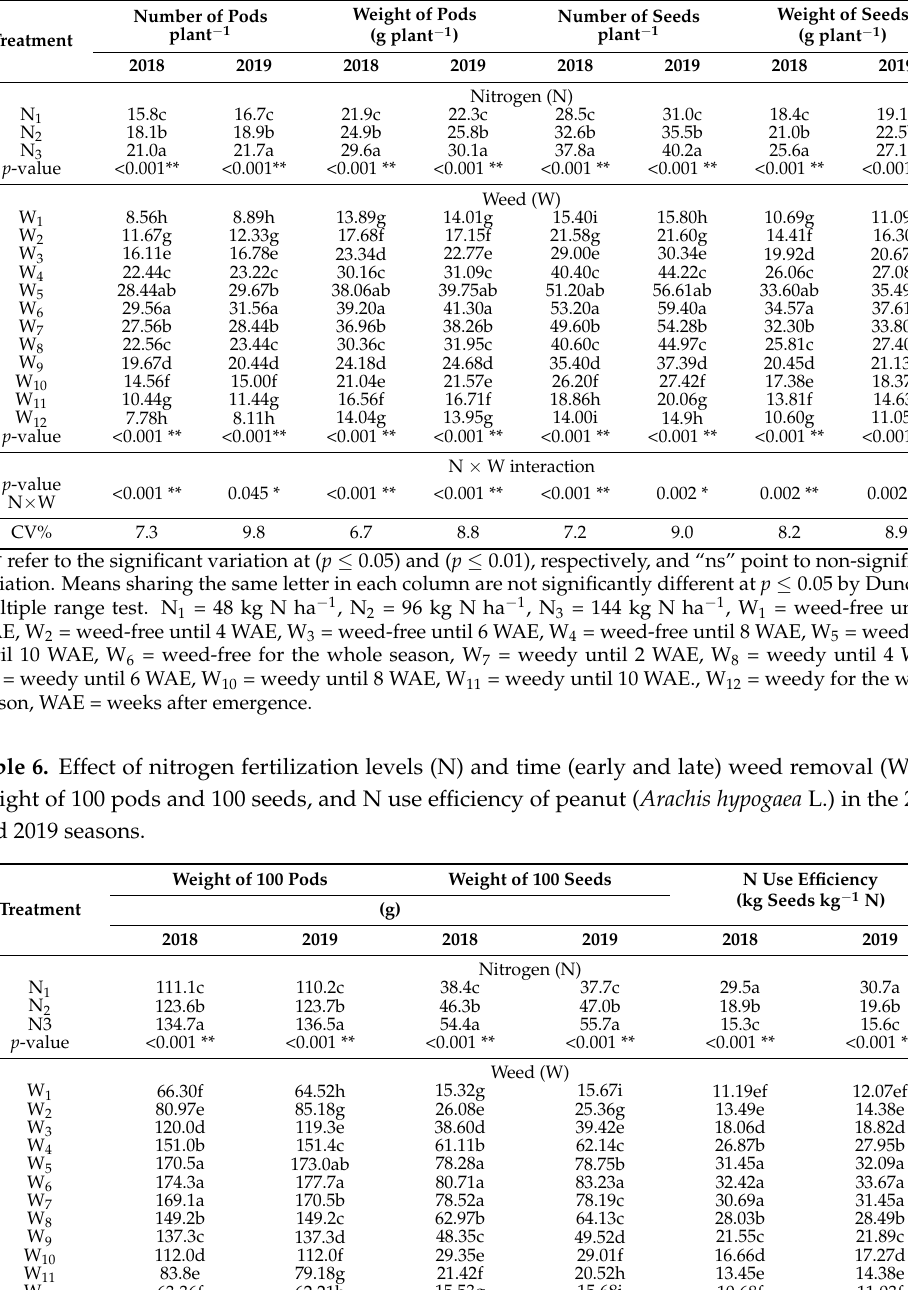
Table 5. Effect of nitrogen fertilization levels (N) and time (early and late) weed removal (W) on number and weight of pods plant − 1 and number and weight of seeds plant − 1 of peanut ( Arachis hypogaea L.) in the 2018 and 2019 seasons.